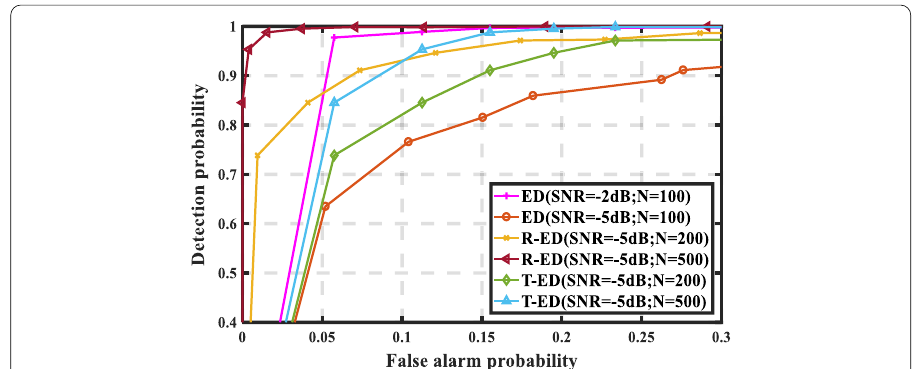
Fig. 4 Sensing performance comparisons of various schemes